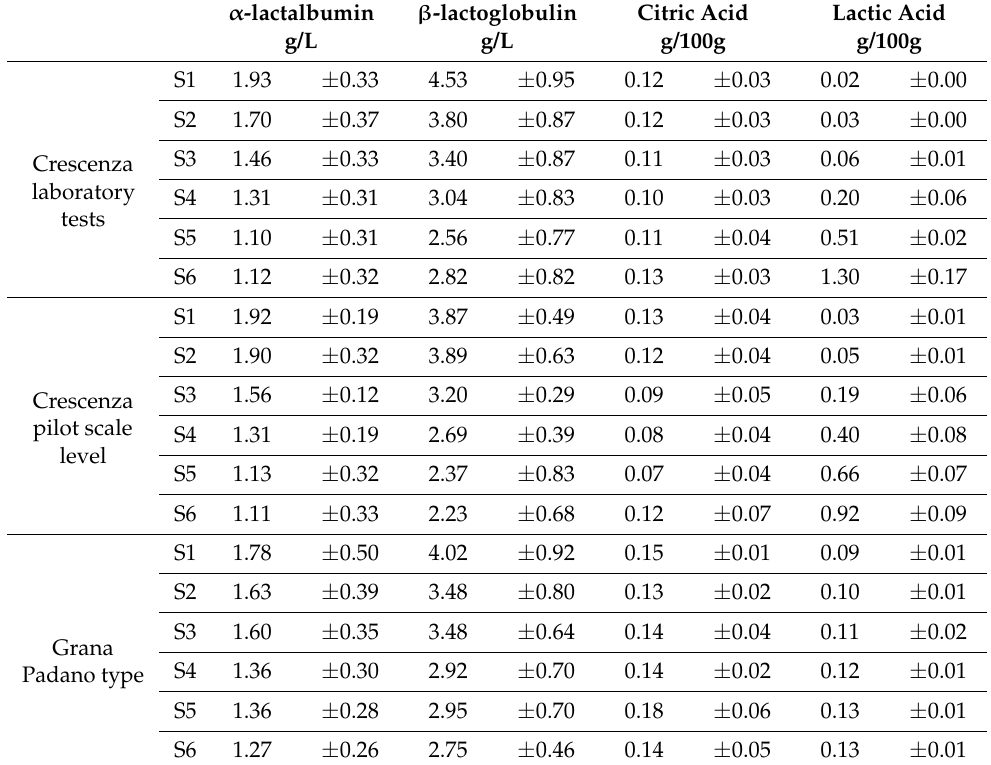
Table 1. Milk-whey proteins and organic acids content during milk whey syneresis. S1–S6: sampling points (see Materials and Methods for